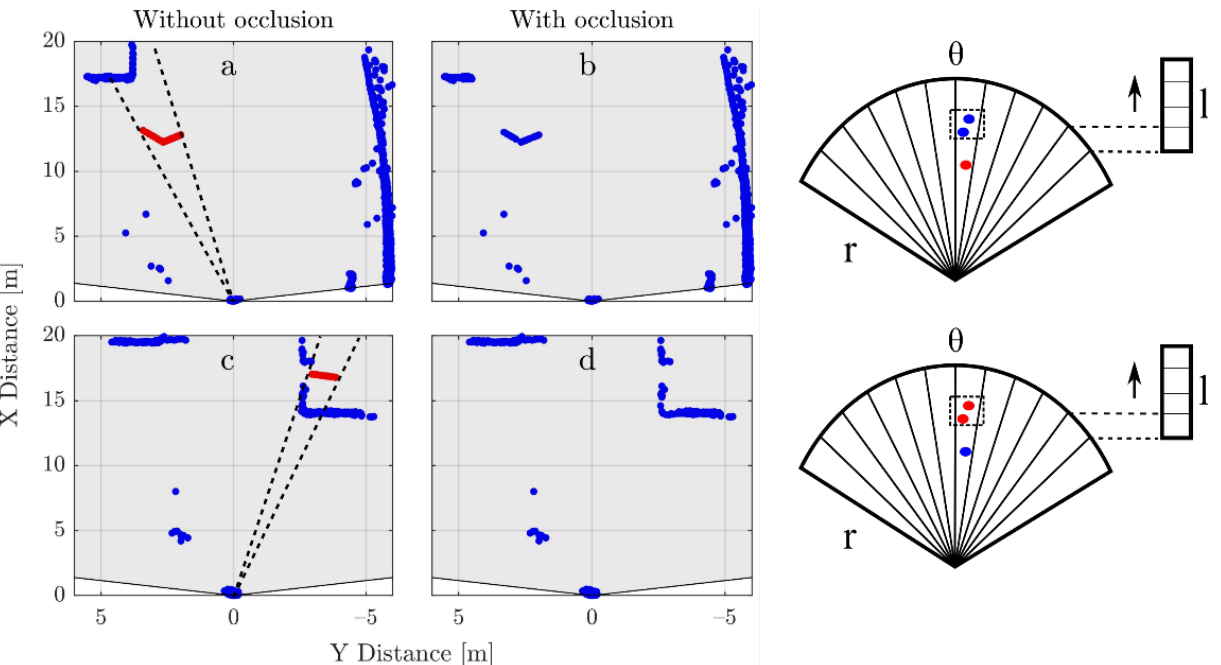
Figure 8. Examples of cases in which occlusion has to be calculated after adding the synthetic object. In ( a ) the detections caused by the LV in the same angular region and layer as the obstacle (dotted line) should be removed. Equivalently in ( c ), the obstacle itself should be removed as its random position happens to be inside another vehicle. The ( b , d ), respectively. The angular bin size needs to be selected to avoid strong undersampling of the point cloud if the value is too high. However, if it is too small, the desired occlusion effect does not take place. In our case, a value slightly higher than the resolution of the sensor was used. The occlusion is calculated before the Gaussian noise is added to the synthetic